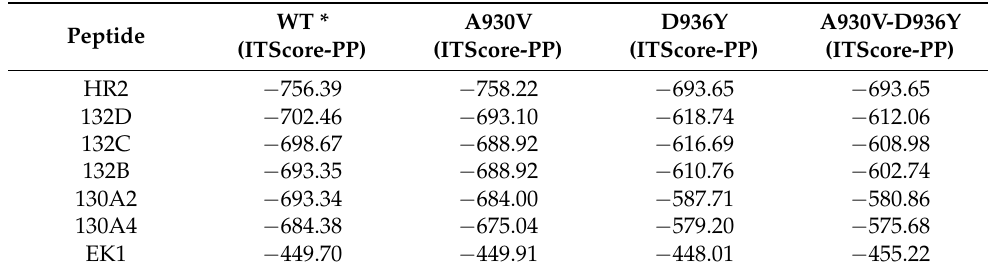
Table 2. HDOCK score of peptides for HR2, EK1, and top five peptide inhibitors to SARS-CoV-2 HR1 A930V, D936Y, and A930V-D936Y mutants. WT * A930V D936Y Peptide (ITScore-PP) (ITScore-PP)